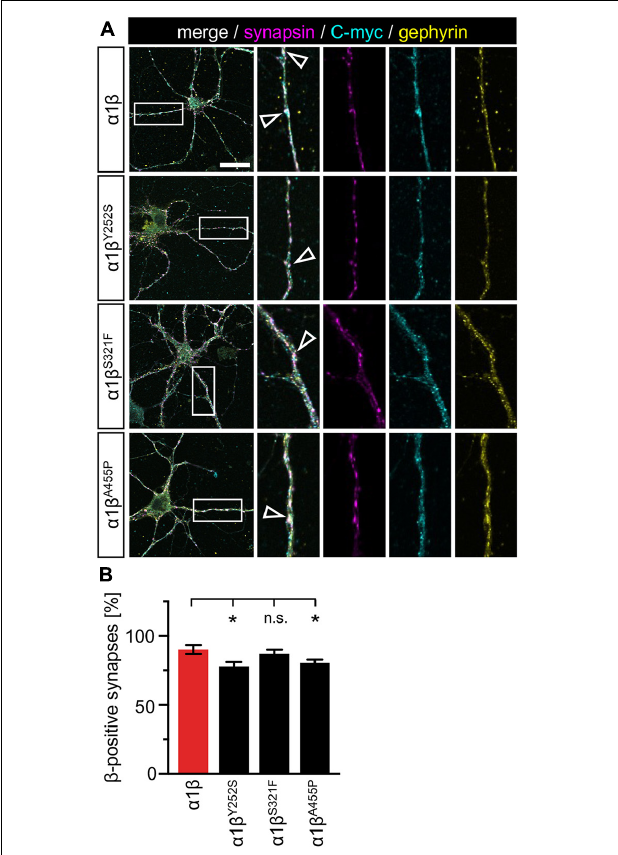
FIGURE 7 | GlyR β variants form clusters with endogenous gephyrin but exhibit less synaptic localization. (A) Hippocampal neurons transfected with α 1 β WT and α 1 β x variants. The GlyR β subunit was detected with a myc-antibody (cyan), as well as endogenous gephyrin (yellow), and synapsin (magenta). White boxes indicate dendritic areas shown in the enlarged images on the right. White open arrowheads show co-localization of GlyR β in gephyrin-positive and synapsin-positive clusters. Scale bar refers to 25 µ m. (B) Quantification of GlyR β -positive synapses. Calculation was performed from 40 to 92 dendrites ( n = 40–92) from transfected neurons obtained from two independent experiments. A ratio of myc-GlyR β -positive synapses versus gephyrin-positive synapses was estimated and is given as β -positive synapses in %. Level of significance * p < 0.05.